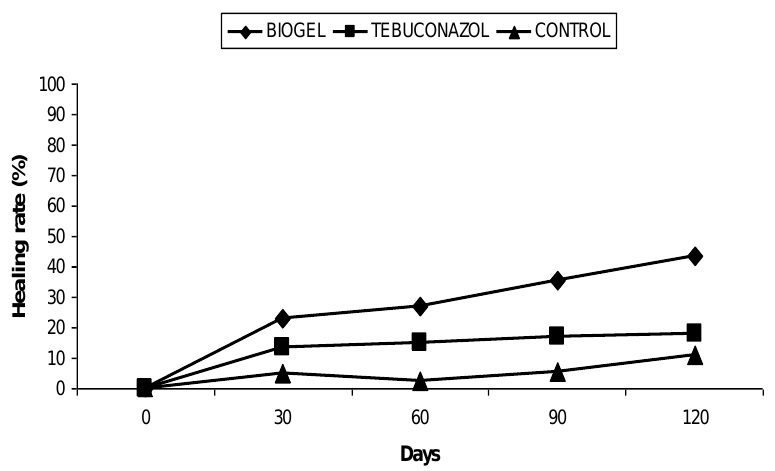
Figure 2. Effect of biogel application on apple canker in the R’Haou at orchard.